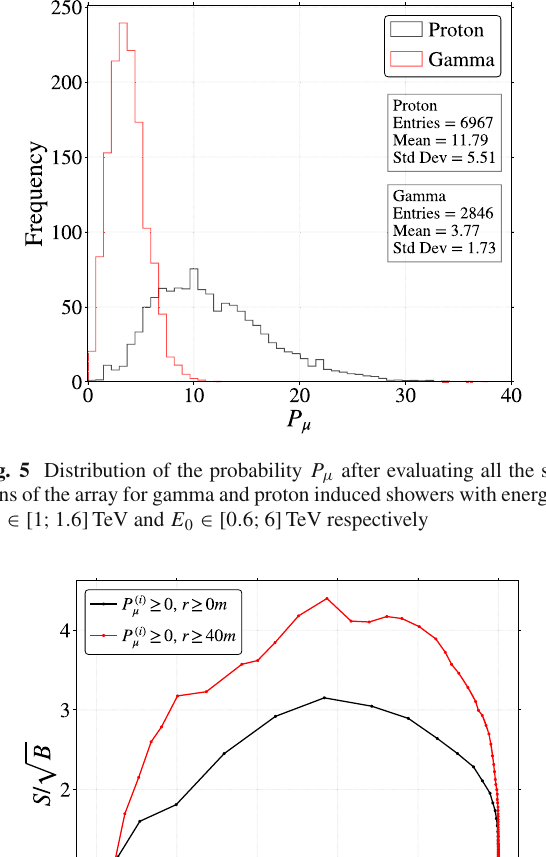
Fig. 6 Evaluation of the S /